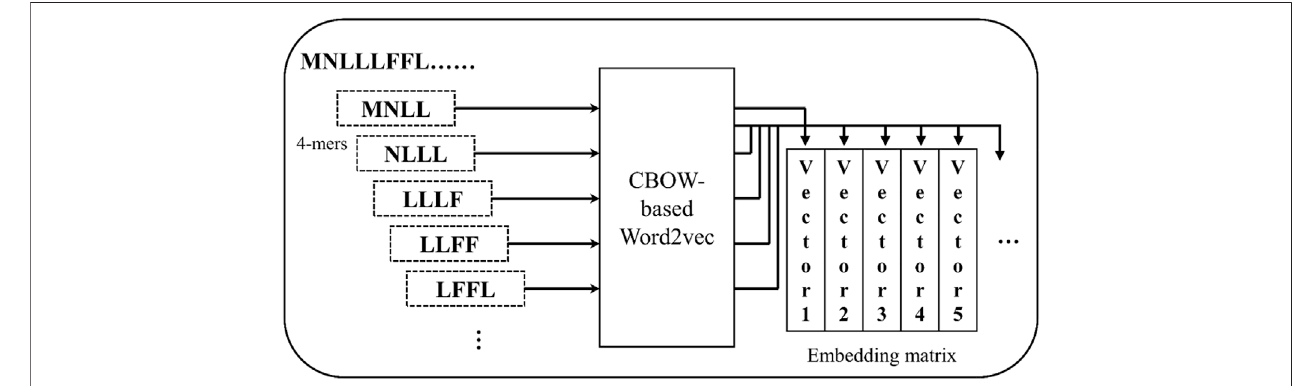
FIGURE 5 | The framework of the word2vec model in the 4-mer